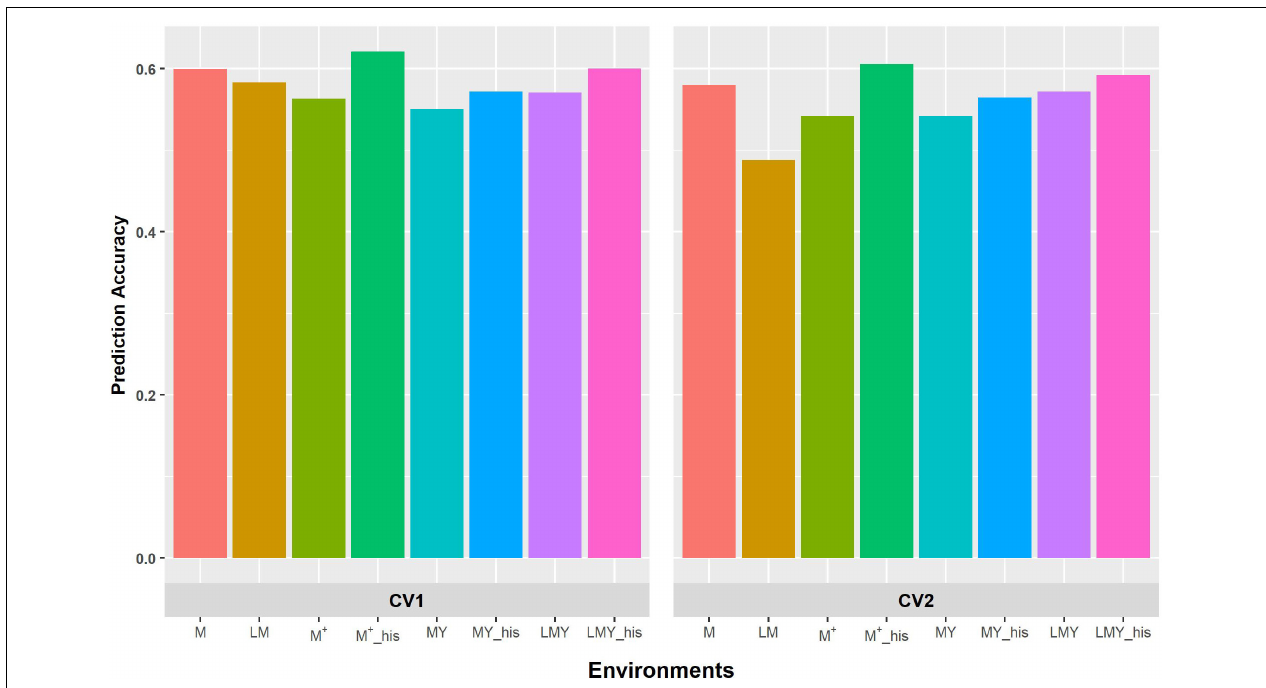
FIGURE 2 | Predictive ability of the factor analytic model for the cross-validation schemes (CV1 and CV2) in WW environments/management. LM and M represent prediction accuracy obtained when covariance was modeled across environments and managements, respectively, for within-year prediction. LMY represents classification of environment as location by management by year, MY and M + represent the broad classification of the management across years as WW and WS, and explicit definition of the management across years as WW 2017 and 2018 and WS 2017 and 2018. LMY, MY and M + used all available historical data. The suffix “his” represents prediction accuracy obtained with optimized historical data using the Avg_GRM genetic optimization criterion.